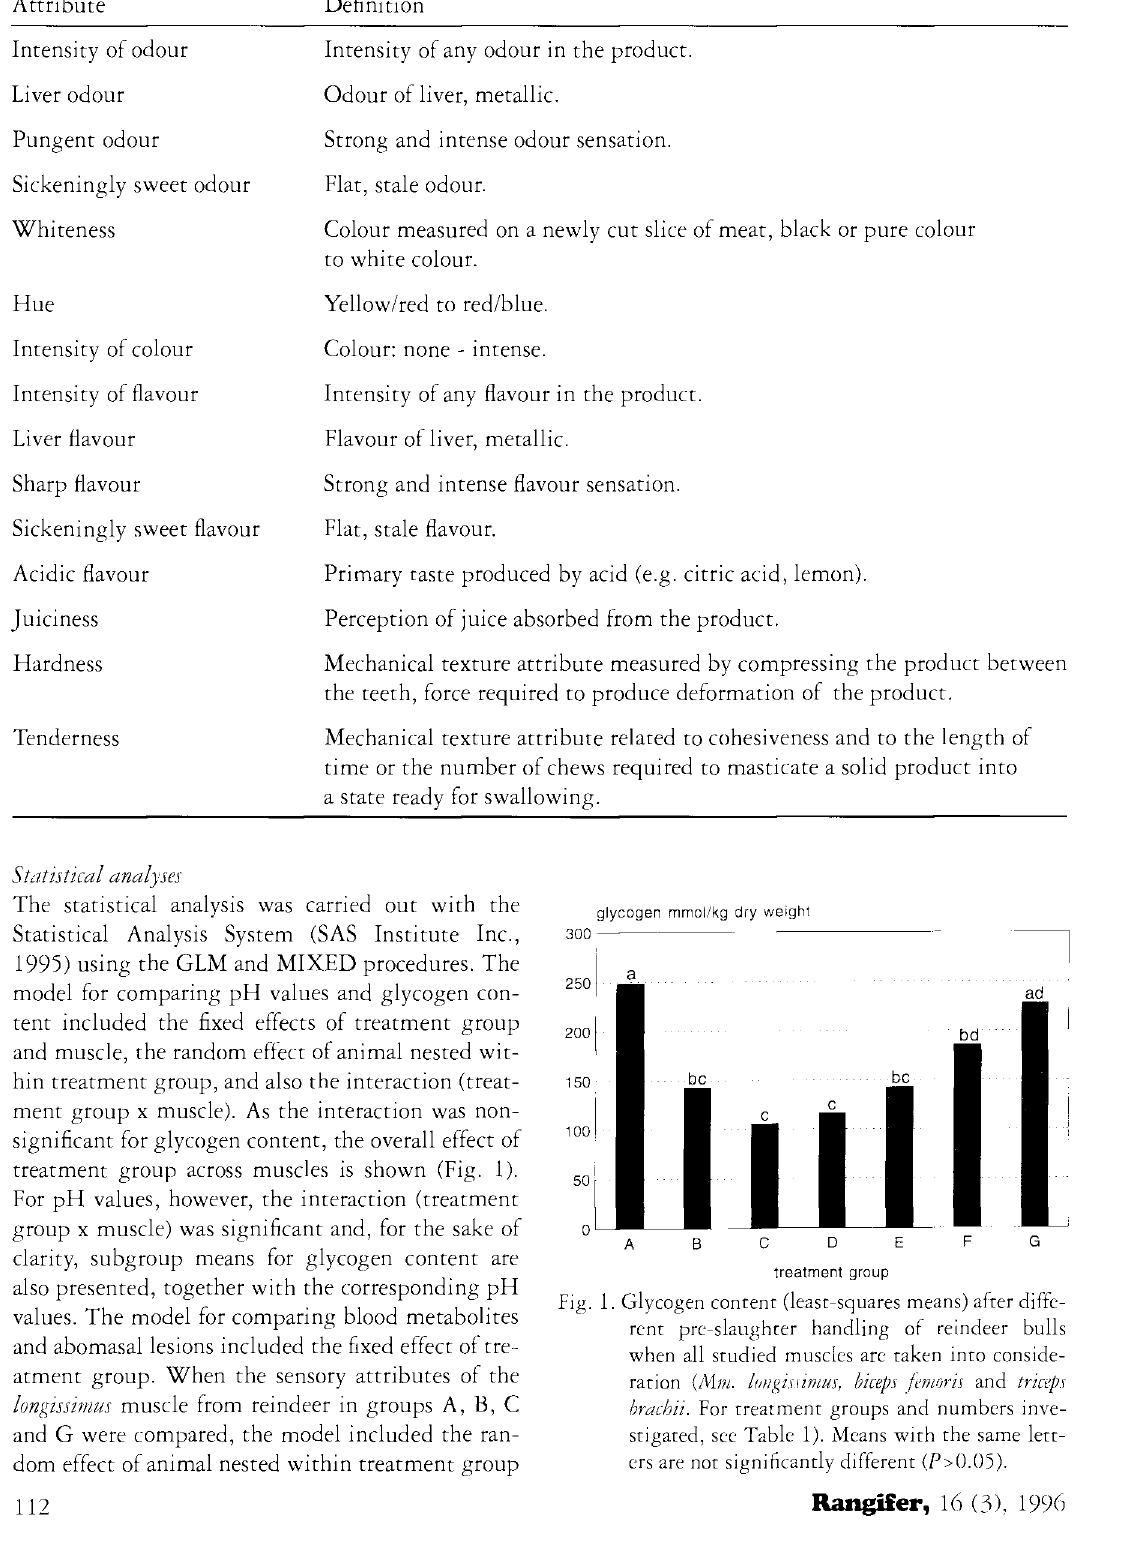
Fig. 1. Glycogen content (least-squares means) after diffe rent pre-slaughcer handling of reindeer bulls when all studied muscles are taken into conside ration (Mm. Itmgisumus, biceps femoris and triceps hrachii. For treatment groups and numbers inve stigated, see Table 1). Means with the same lett ers are not significantly different